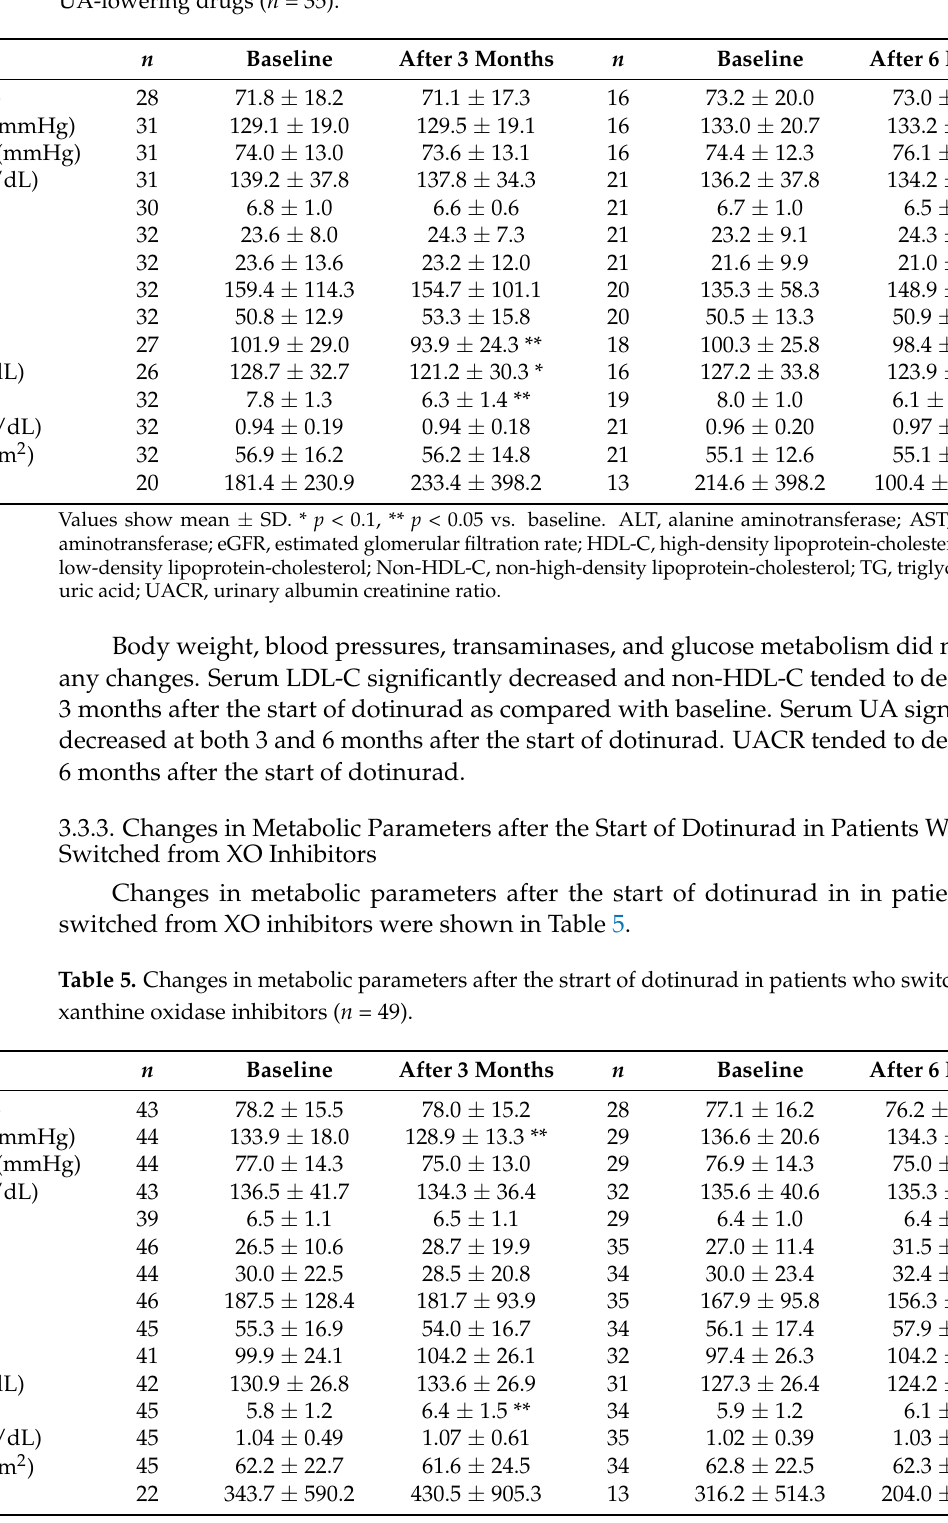
Table 4. Changes in metabolic parameters after the start of dotinurad in patients who had not used UA-lowering drugs ( n = 35).